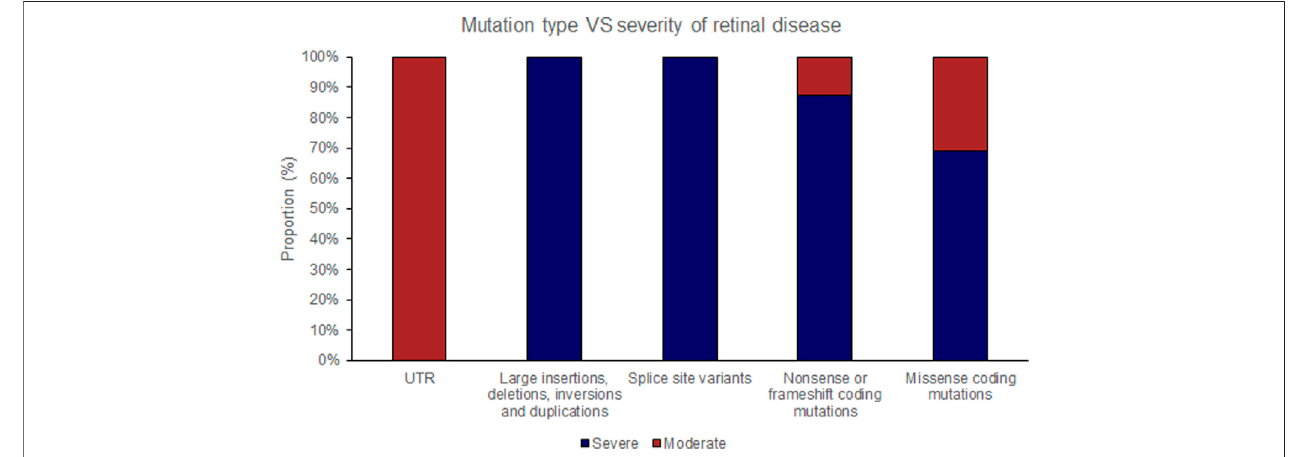
FIGURE 4 | Pathogenic variants ( ‘ mutations ’ ) were classi fi ed by type (UTR [untranslated region], large insertions, deletions, inversions and duplications, splice site variants, nonsense or frameshift coding mutations and missense coding mutations). The proportion of mutations of each type that causes either ‘ severe ’ or ‘ moderate ’ retinopathy is shown.